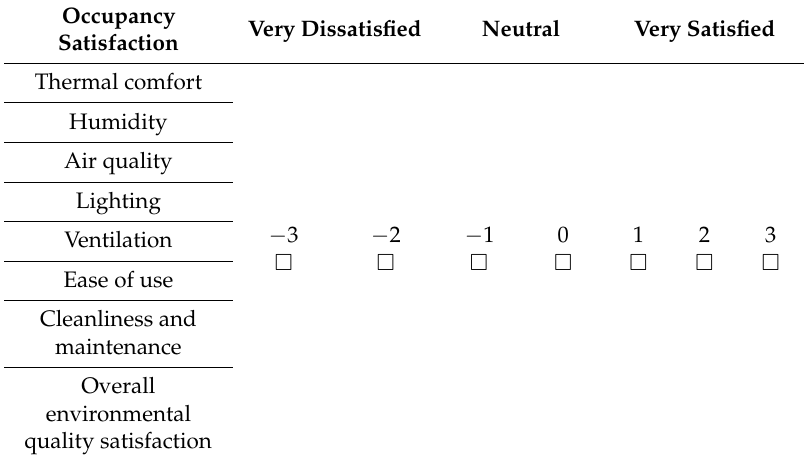
Table 10. Questionnaire for the occupancy satisfaction survey.